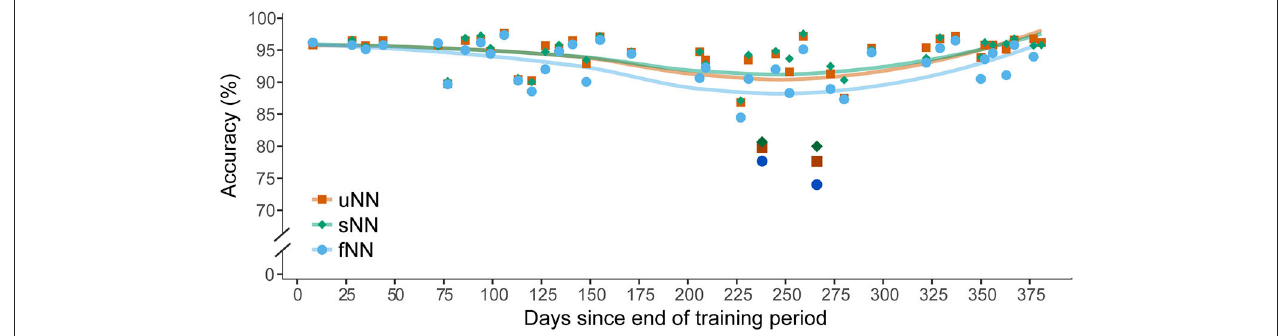
FIGURE 10 | Recording disruptions impair motor intention decoding in a BMI clinical trial. The performance of three deep neural network decoder variants were evaluated for a four-movement motor imagery task over the span of 1 year. Accuracies are plotted as a function of the number of days since the end of the neural network training period. Lines denote a LOESS smoothing curve to visualize the data trends. The fixed neural network (fNN, cyan circles) decoder parameters remained unchanged for the duration of the evaluation. The other networks were updated each session with data from a preceding recording block with either explicit training labels (sNN, green diamonds) or with labels predicted by the decoder (uNN, orange squares). Both the sNN and uNN can adapt to daily changes in recording conditions and thus outperform the fNN. On days 238 and 266 (darkened data points) a disruption caused a substantial drop in accuracy for all decoding models. These dates corresponded to times when the participant had undiagnosed infections. Though the adaptive decoders are better able to compensate for this disruption, additional algorithmic interventions are needed to prevent sharp declines in decoding accuracy. Figure adapted with permission from Schwemmer et al. (2018) . Copyright 2018, Springer